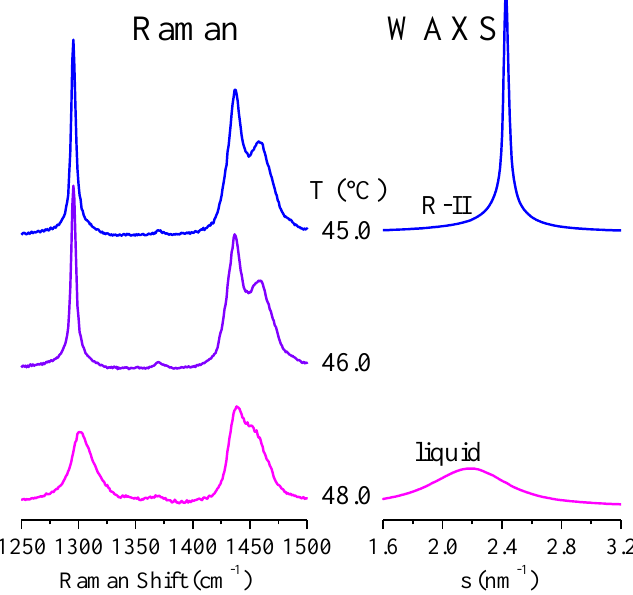
Figure 8. The CH 2 twist and CH 2 bend regions of the Raman spectra for sample C 23 H 48 in the transition from the rhombohedral R-II rotator phase to the liquid state. The corresponding WAXS diffractograms are also shown at the right.